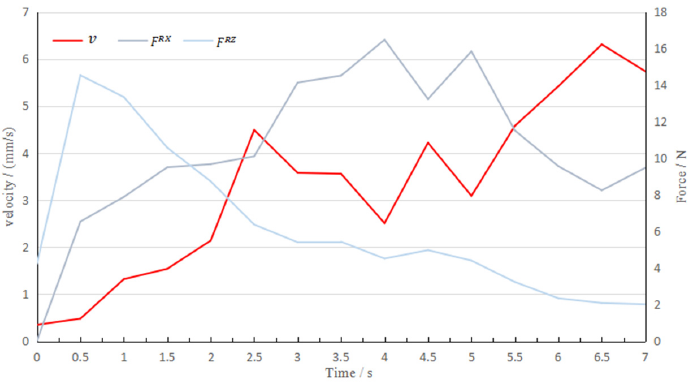
Figure 12. Velocity and the force in the two directions over time in the 20th